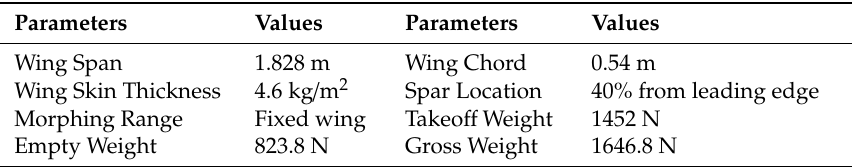
Table 1. Detailed specifications of RQ-7, aircraft model for study.